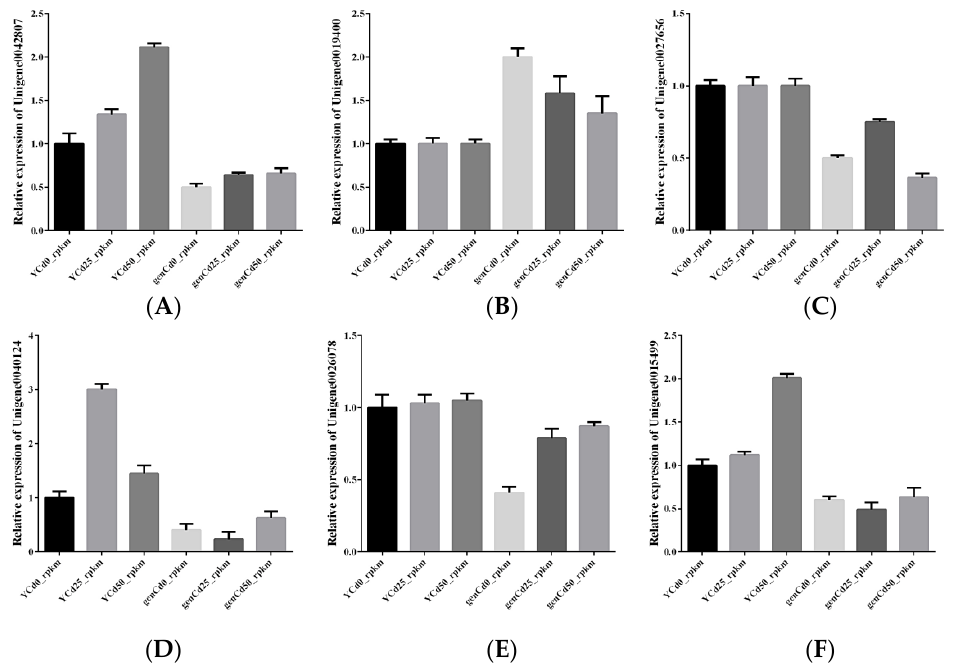
Figure 8. RT-qPCR results of six transcription factors: ( A ) Unigene0042807; ( B ) Unigene0019400; ( C ) Unigene0027656; ( D ) Unigene0040124; ( E ) Unigene0026078; ( F )